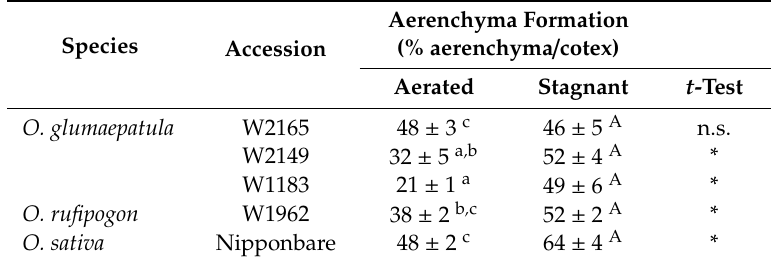
Table 1. Aerenchyma formation (% aerenchyma / cortex) in accessions of O. glumaepatula , O. rufipogon , and rice (cv. Nipponbare) under aerated or stagnant conditions.